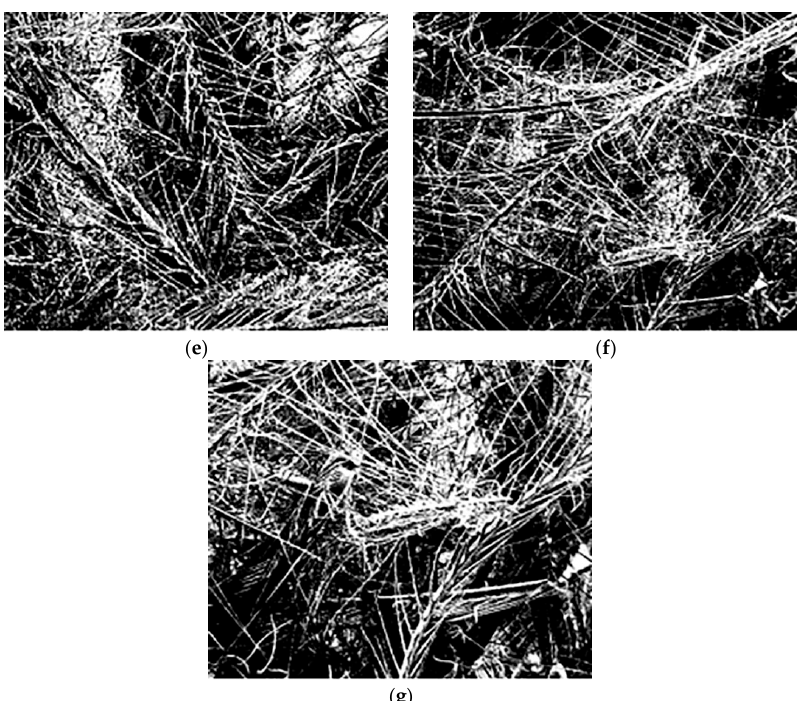
Figure 10. Images of pre-processed samples (#1–7) ( a – g ).